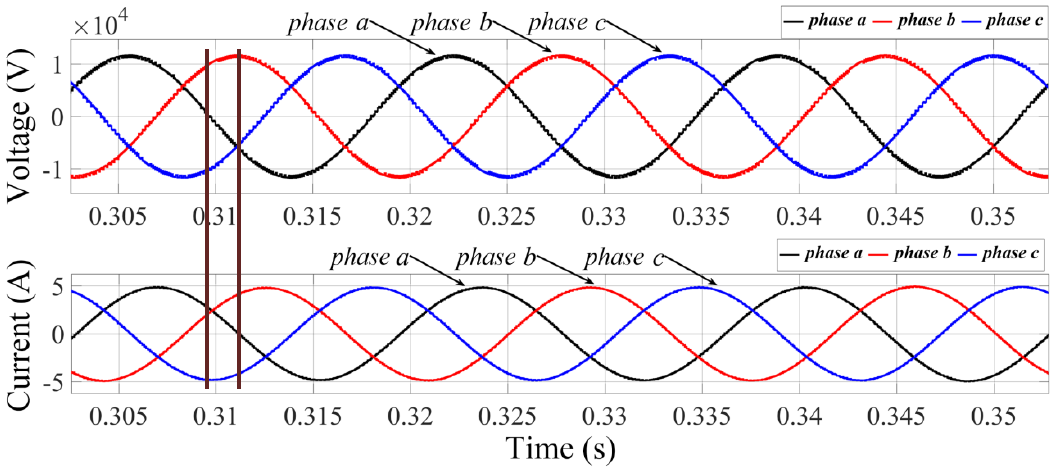
Figure 10. Direct axis current (blue) and quadrature axis current (red) measured at high voltage (HV) of system to F p = 0.85. Vertical axis: 2 A/div. Horizontal axis: 100 ms/div.